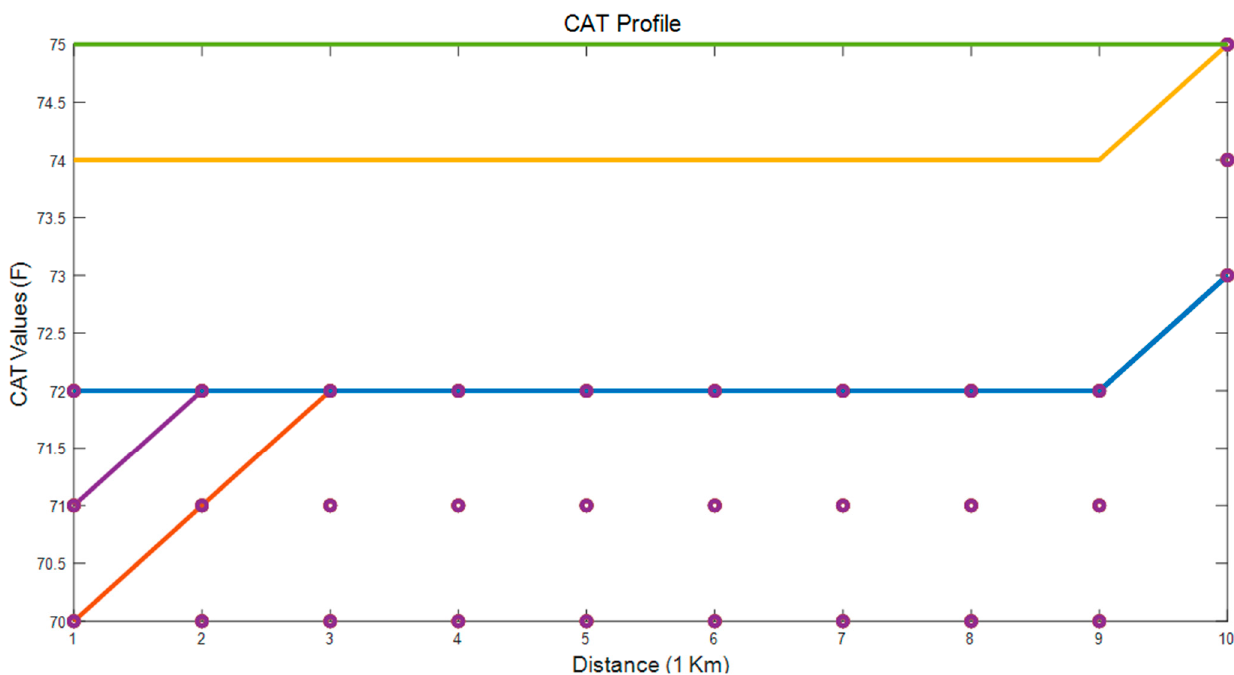
Figure 9. ACCSSP = 70 MPH; CAT = [70 75] °F; EAT = 38.3 °F.